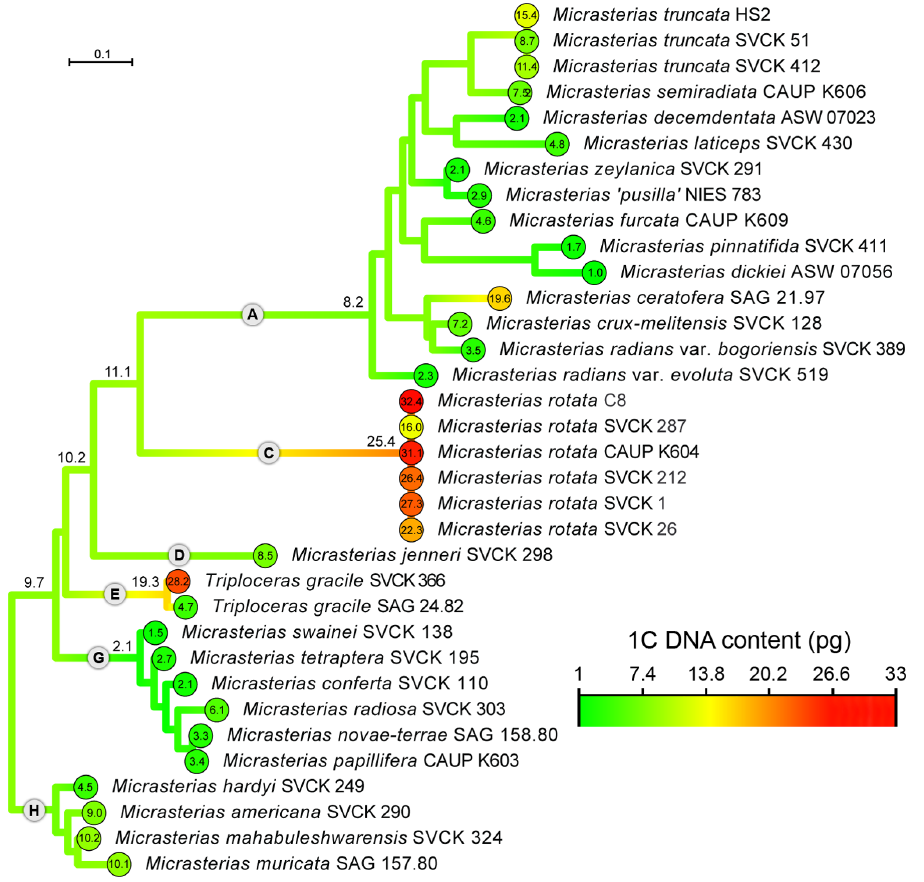
Figure 1. Estimated evolution of DNA content mapped onto the phylogenetic tree of Micrasterias (maximum likelihood method). The phylogenetic analysis was conducted on the alignment published by Sˇkaloud et al. [40]. Species affiliation to eight clades (A–H) is indicated. Estimated 1C DNA content is shown at the base of each clade. Scale bar – estimated number of substitutions per site.